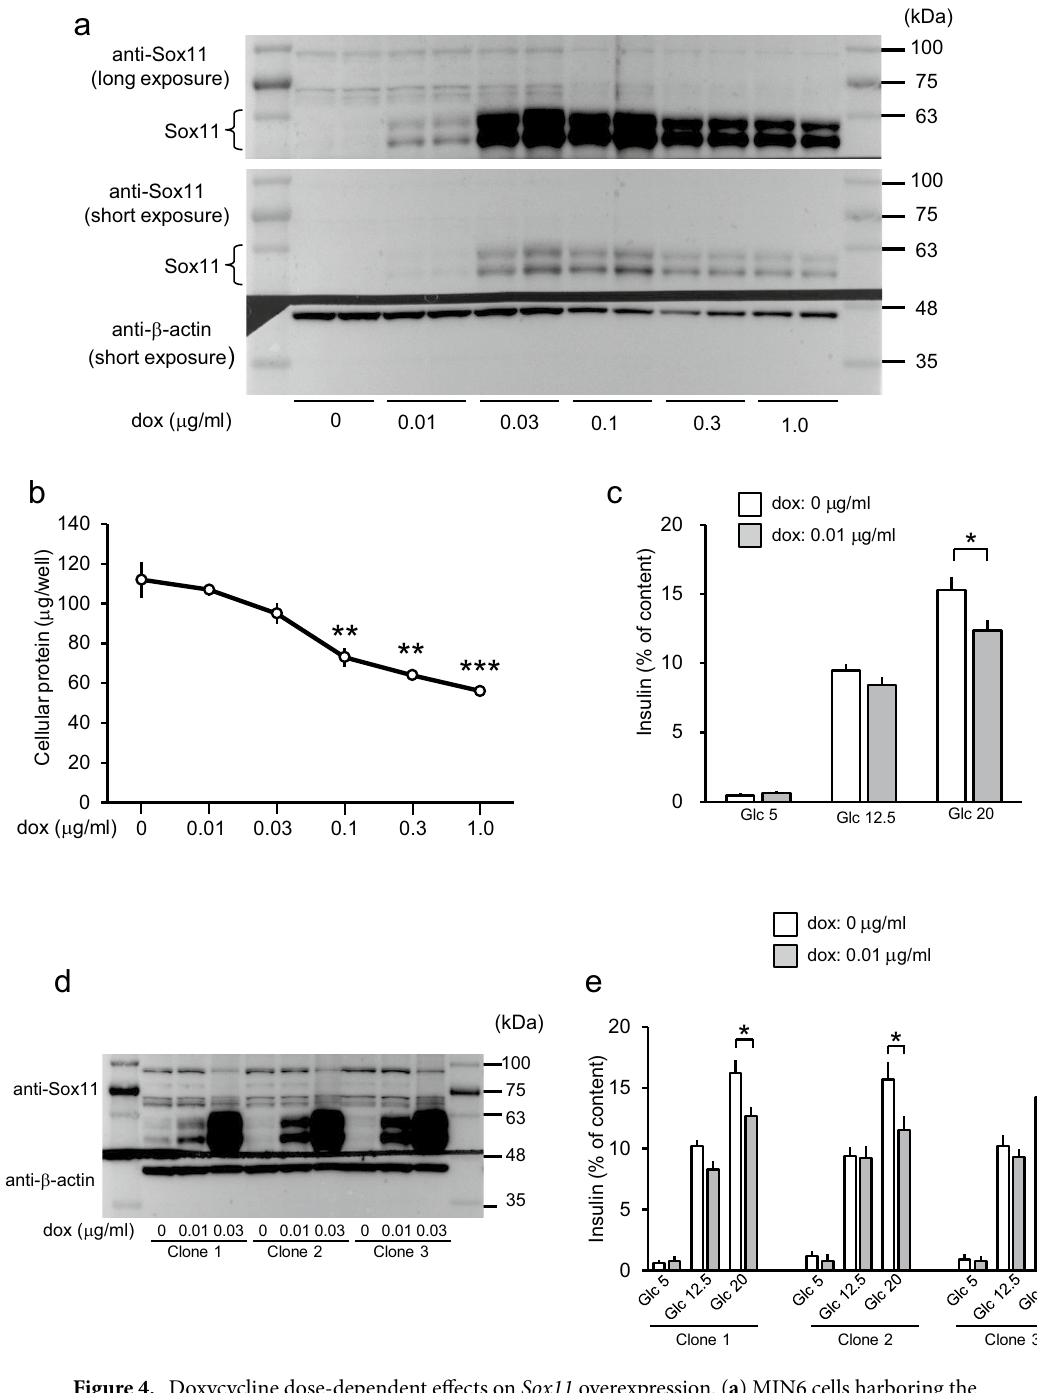
Figure 4. Doxycycline dose-dependent effects on Sox11 overexpression. ( a ) MIN6 cells harboring the tetracycline-dependent Sox11 expression unit were cultured for 2 days with different concentrations of dox and subjected to Western blot analysis. Membranes were cut just above the 48 kDa marker levels and probed with anti-Sox11 or anti-β-actin antibody. The representative blot shown is from 3 experiments. Uncropped images are presented in Supplementary Fig. S3. ( b ) MIN6 cells treated as in ( a ) were dissolved with 1N NaOH and protein concentrations were determined with the Pierce protein assay reagent. Data are means ± SEM, n = 3 experiments. ** P < 0.01, *** P < 0.001. ( c ) GSIS from 0.01 μg/ml dox-treated and -untreated MIN6 cells harboring the Sox11 expression unit. Data are presented as means ± SEM, n = 3 experiments. * P < 0.05. ( d ) Western blot analyses were performed using subclones overexpressing Sox11 as described in ( a ). The representative blot shown is from 2 experiments. Uncropped images are presented in Supplementary Fig. S5. ( e ) GSIS from 0.01 μg/ml dox-treated and -untreated subclones harboring the Sox11 expression unit. Data are presented as means ± SEM, n = 3 experiments. * P <